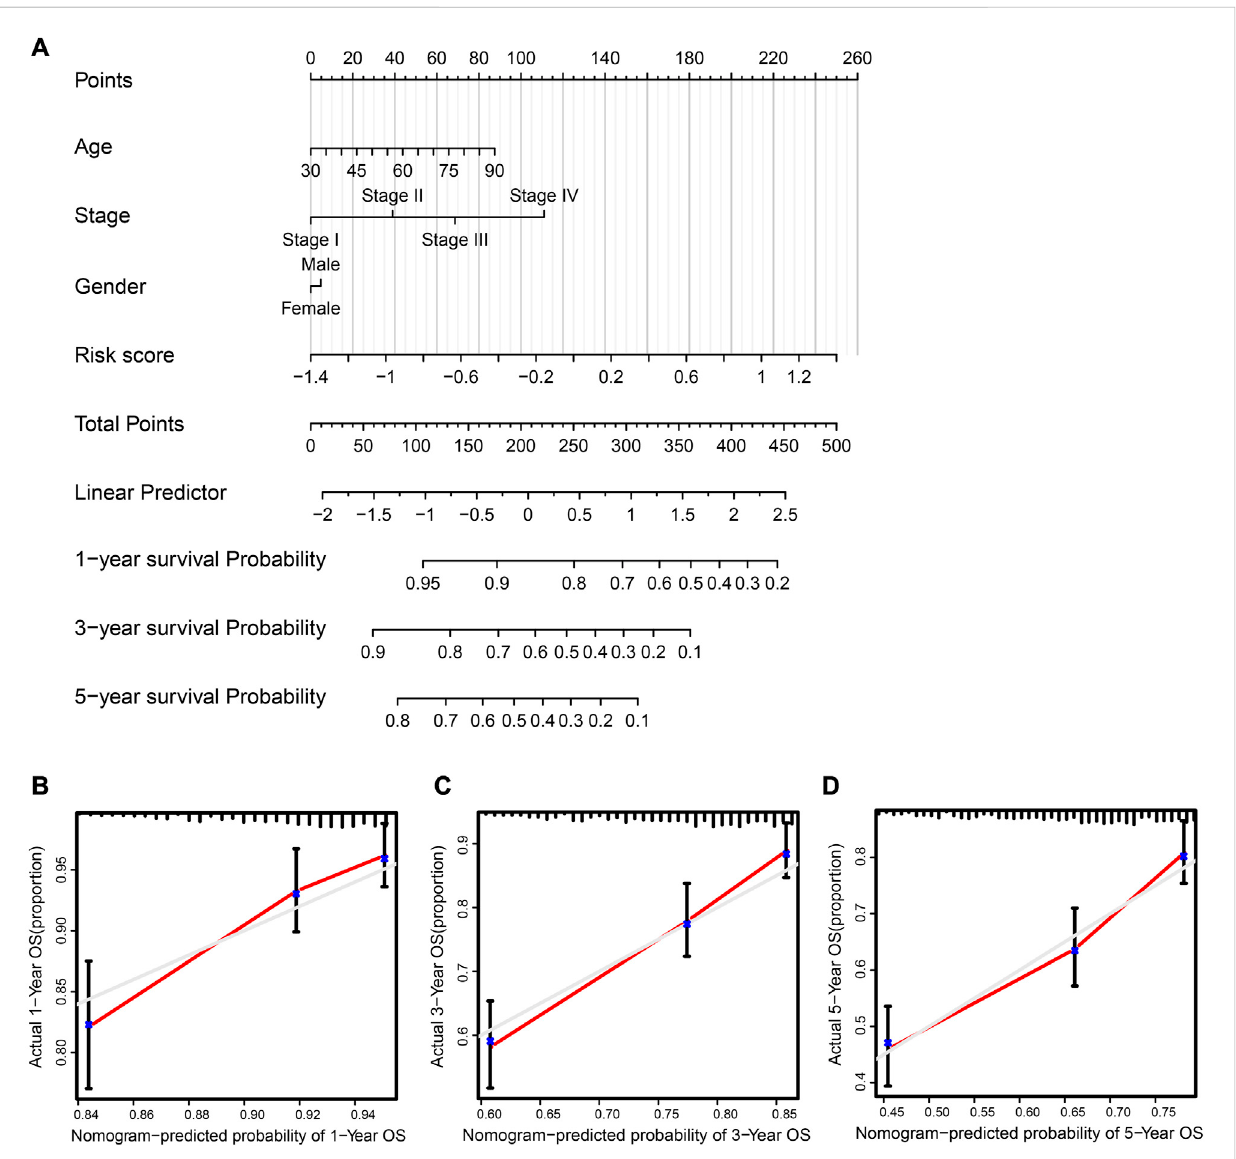
FIGURE 6 Clinical prognostic nomogram was created and validated. (A) Nomogram, taking into account risk score, tumor stage, age, and sex, predicted the likelihood of 1-, 3-, and 5-year OS. (B – D) 1-, 3-, and 5-year OS calibration curves; predictedsurvival probability graphed along the x-axis, whereas actual survival probability is represented along the